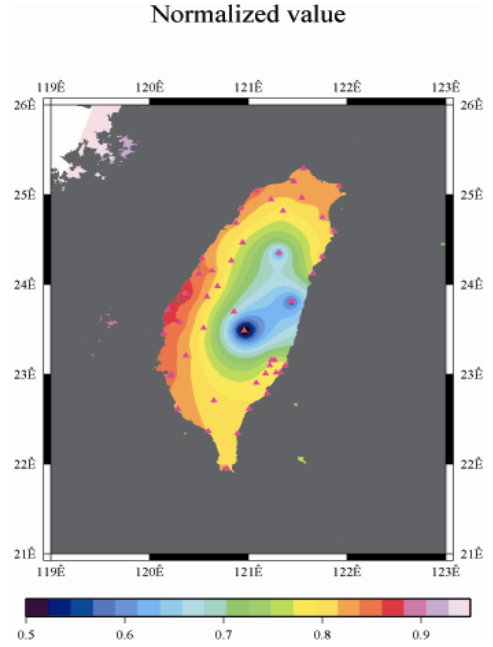
Figure 11. Normalized ZTD values around the island when the typhoon was striking Taiwan (September 14th, 2008, 1:00 PM).